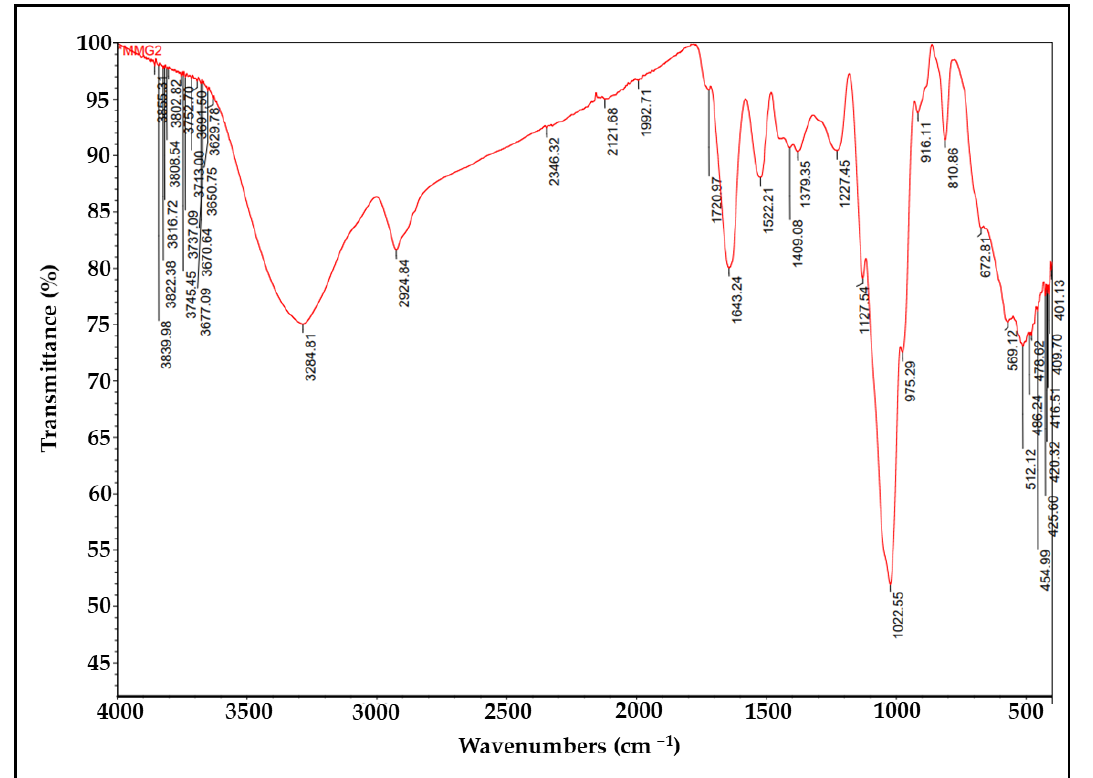
Figure 4. FTIR analysis of EPS produced by Lysobacter sp. MMG2